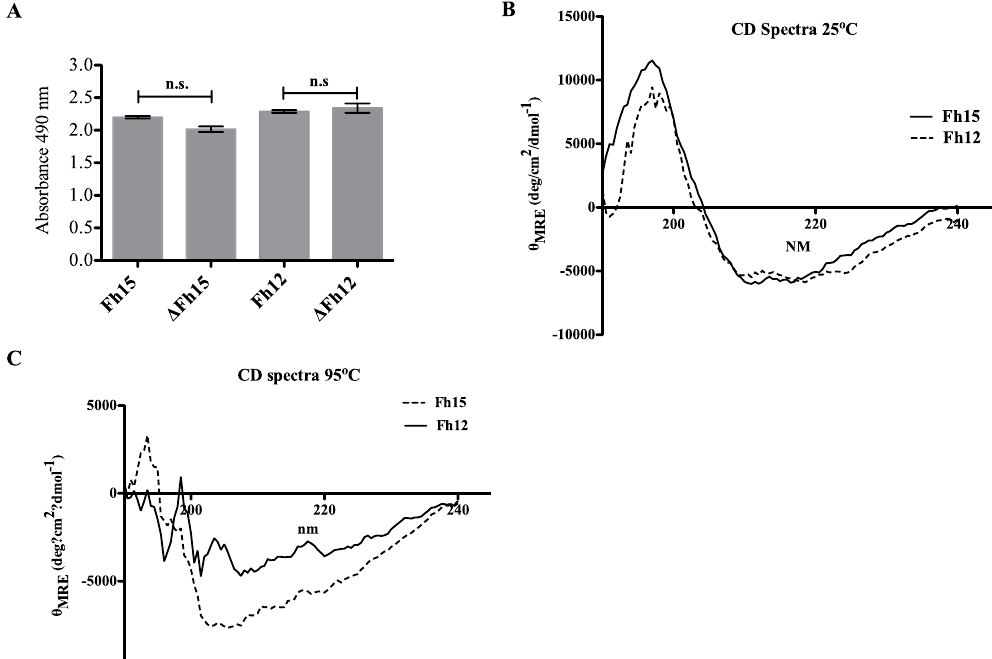
Figure 3. Immunoreactivity of Fh12 and Fh15 and Circular Dichroism spectra of Fh12 and Fh15 before and after a denaturing heat treatment. ( A ) Indirect ELISA was used to evaluate the immunoreactivity of Fh12 and Fh15 against the anti-Fh12 antibody diluted 1:200 in PBST before (Fh12 or Fh15) and after heat treatment ( Δ Fh12 or Δ Fh15). No significant (n.s.) differences were found between the absorbance values of Fh12 and Δ Fh12 or between Fh15 and Δ Fh15. ( B ) CD spectra of Fh15 (solid line) and Fh12 (dashed line). Spectra was obtained at 25 °C using each protein at 0.1 mg/ml. ( C ) CD spectra of Fh15 and Fh12 after denaturing temperature treatment of 95 °C using each protein at 0.1